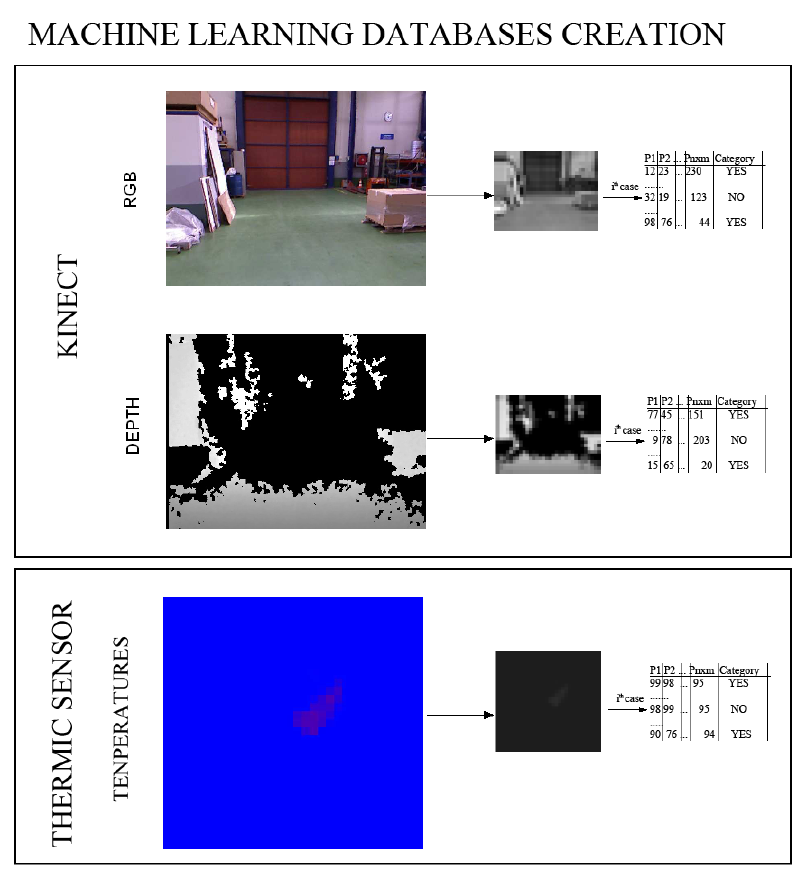
Figure 5. Image preprocessing and training database creation from a hand-labeled original dataset and transformed images.